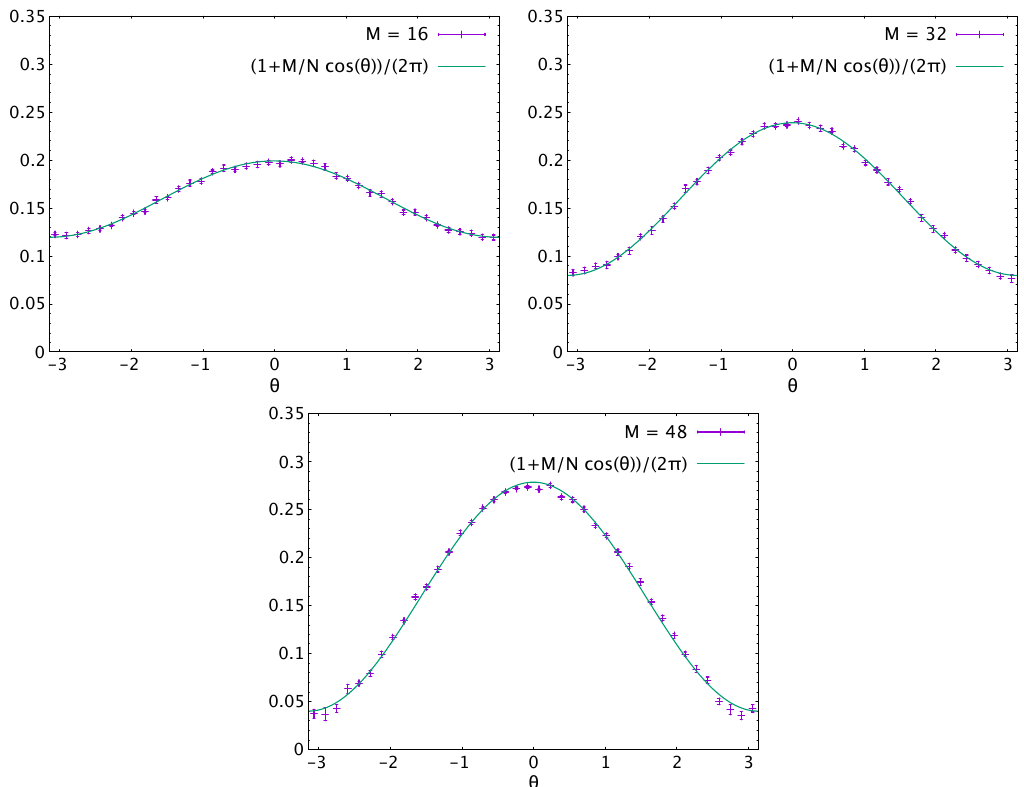
Figure 13. Yang-Mills matrix model, the distribution of the phases of the Polyakov loop ρ (P) ( θ ) obtained from constrained simulations, N = 64 , L = 24 , M = 16 , 32 , 48 , and T = 0 . 885 . The green (cid:0) (cid:1) lines are 1 1 + M cos θ . The center symmetry is fixed sample by sample such that P = | P | . The 2 π N error bars in each figure are obtained by jackknife analysis.